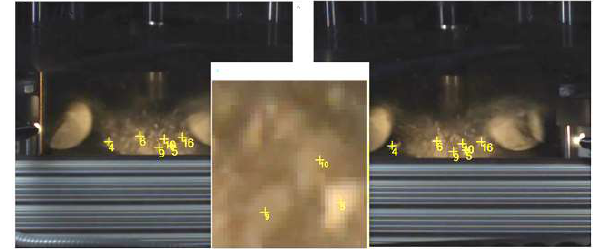
Figure 6. Manual measurement of progeny particles.